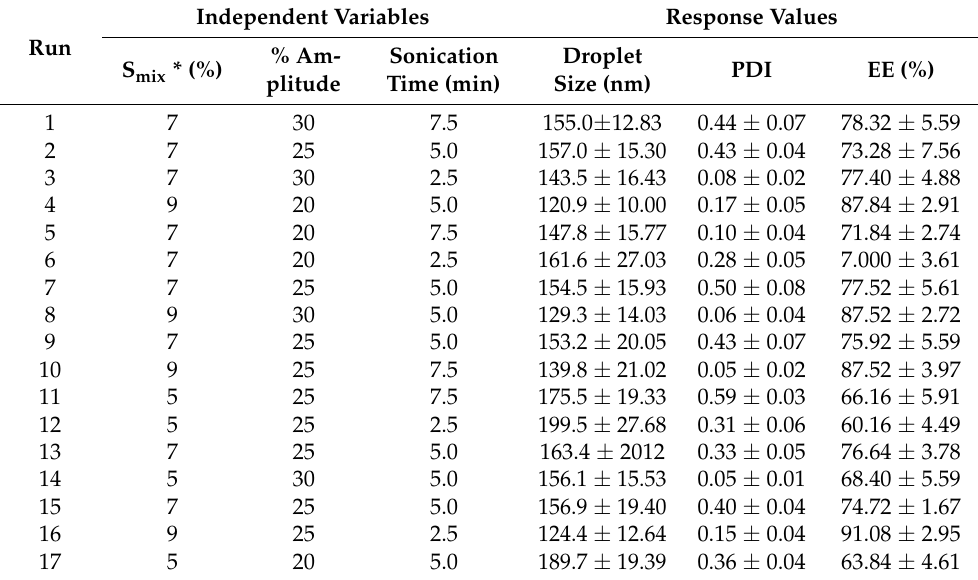
Table 1. Box–Behnken design for Que-NE with independent variables and their response values (Supplementary Figure S2).